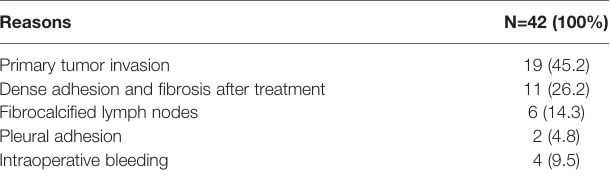
TABLE 4 | Reasons for unexpected conversion from VATS to open thoracotomy.